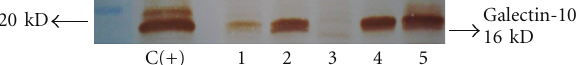
Figure 4: Western blot analysis of galectin-10 in supernatant of lysed nasal polyp from an aspirin-tolerant asthma polyp (lane 1), aspirin sensitive respiratory disease nasal polyps (lane 2, 4, and 5) and nasal mucosa as a tissue control without inflammatory process (lane 3). C(+) protein extract of eosinophils. (First lane, molecular weight